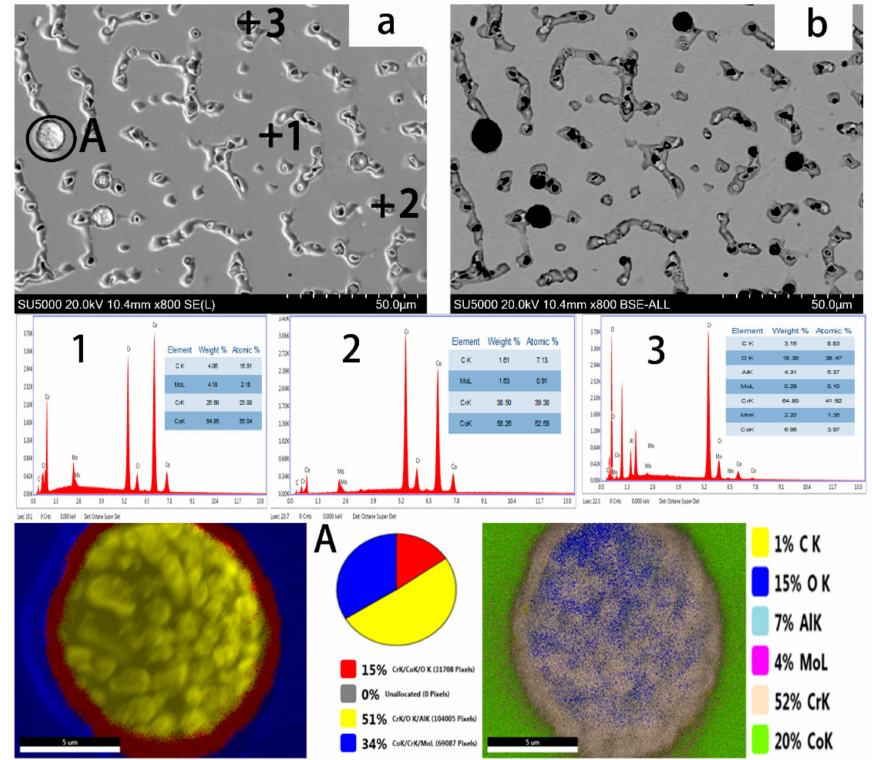
Figure 8. Microstructural analysis of 5% Al 2 O 3 sample. ( a ) Microstructure of 5% alloy with Al 2 O 3 content; ( b ) backscatter scanning imaging